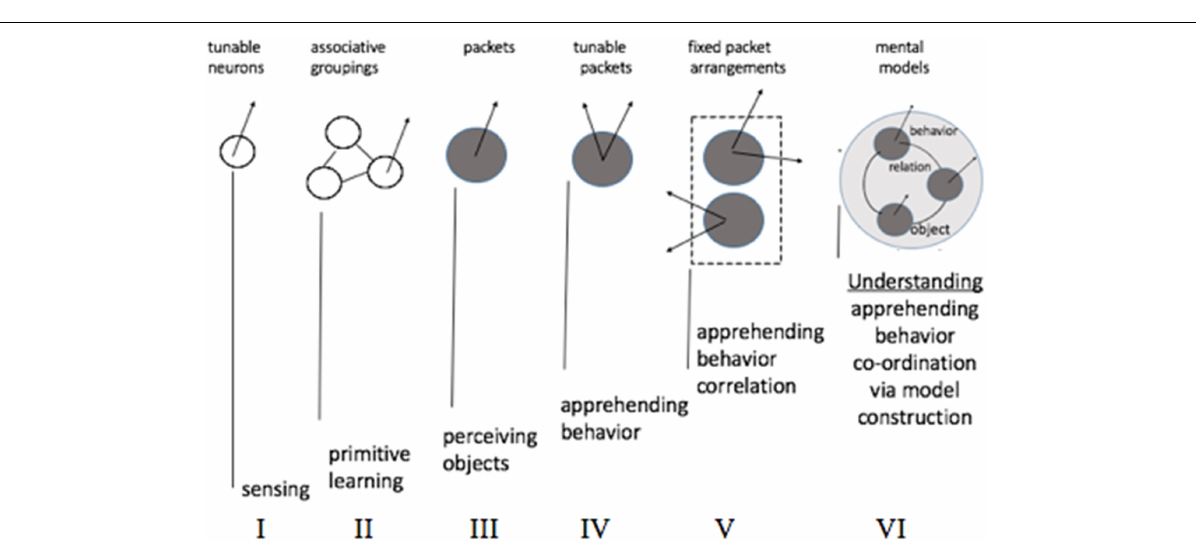
FIGURE 14 | VAN identifies six basic mechanisms employed by the brain to produce adaptive responses to variations in the world stream. The mechanisms vary from tuning receptive fields in individual neurons (I) to constructing and manipulating mental models (VI) . Gnostron architecture integrates these